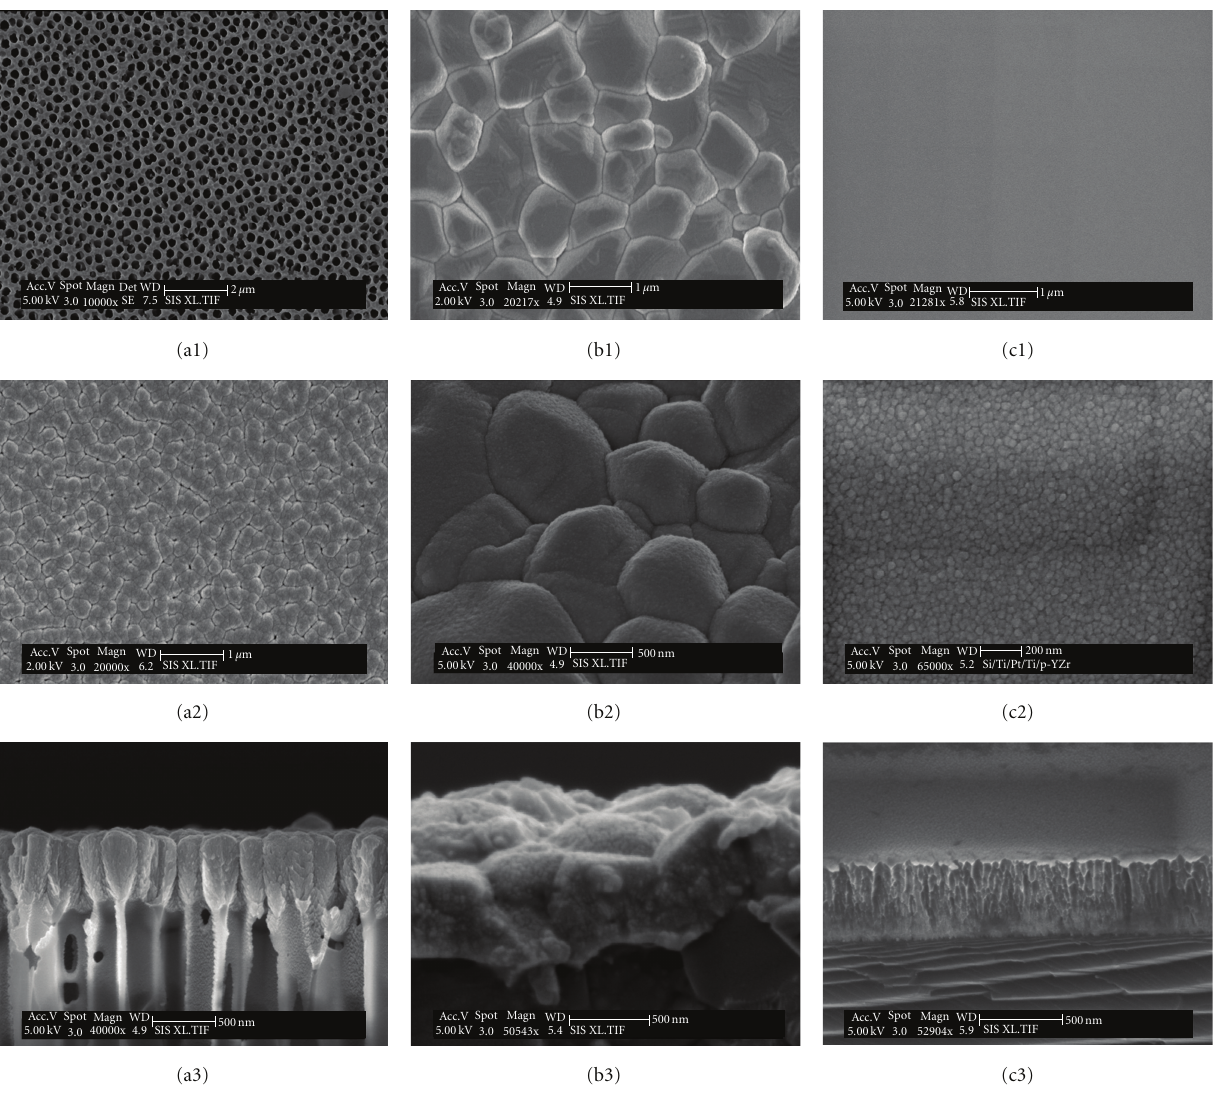
Figure 1: SEM images of the top-view substrates (a1) nanoporous anodized alumina, (b1) nonporous alumina plate, (c1) smooth single crystal Si wafer with 500nm thick silicon nitride layer, top-view (a2, b2, c2) and cross-view (a3, b3, c3) of the as-deposit Y/Zr films. The deposition conditions are 200W, 0.5Pa, and 80s at room